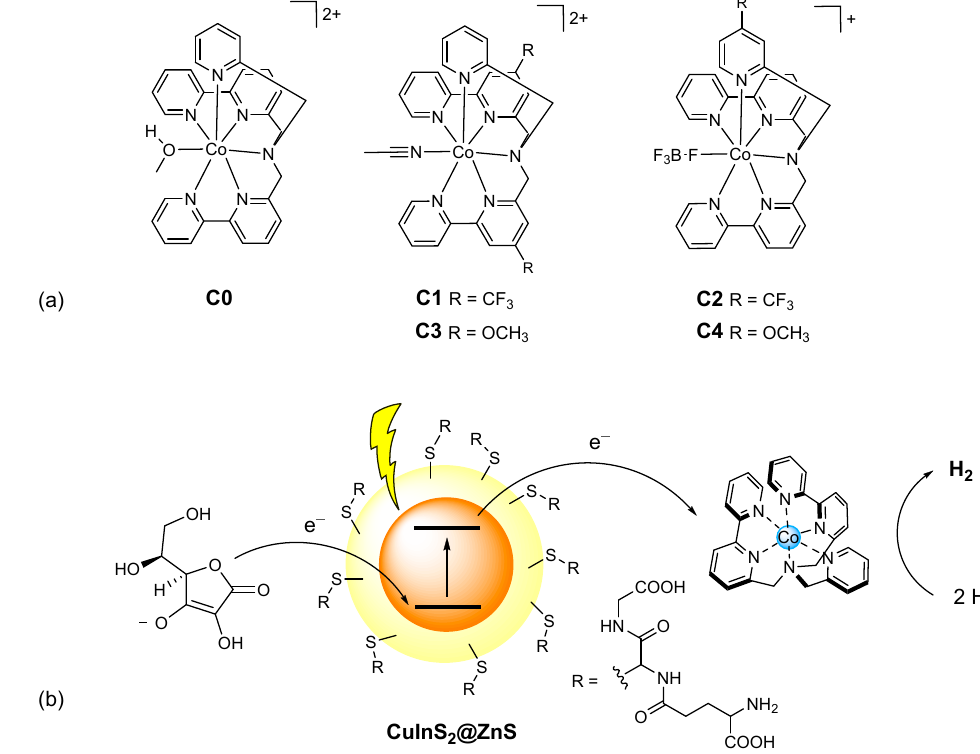
Figure 1. ( a ) Molecular structure of the cobalt complexes C0–4 ; ( b ) schematic representation of the photochemical system here examined involving glutathione-capped core-shell CuInS 2 @ZnS QDs as the sensitizer, ascorbate as the sacrificial donor and the cobalt complexes C0–4 as the HECs.